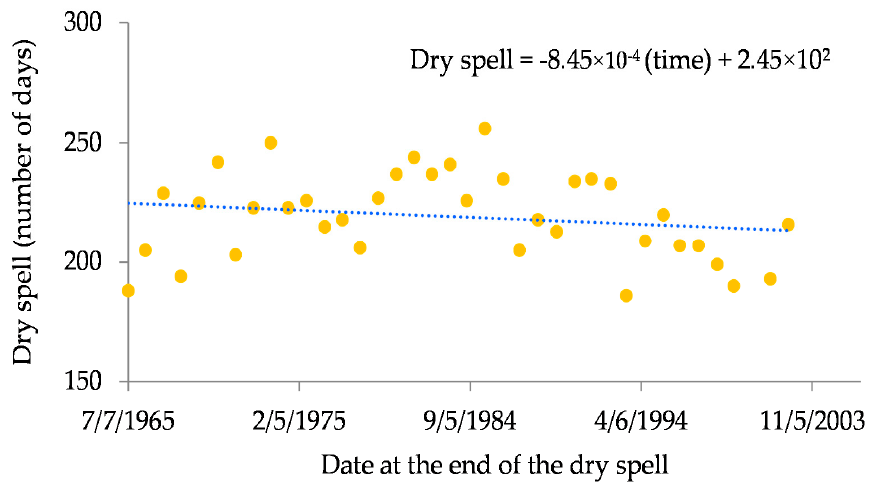
Figure 2. Hydrological dry spells after passing 15-day smoothing or averaging window through daily flow time series at Khartoum from 1965 to 2002. The dotted line is a linear trend.